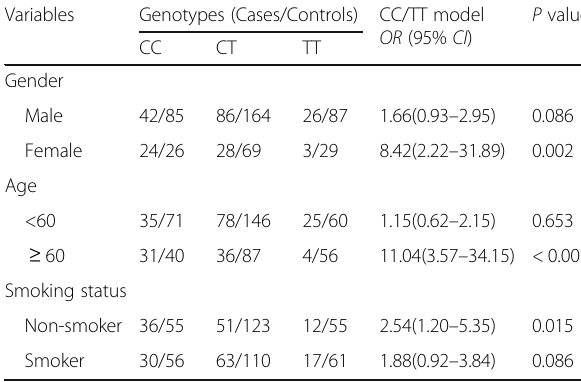
Table 3 Genotype frequencies of TNFSF15 polymorphisms and their association with NSCLC